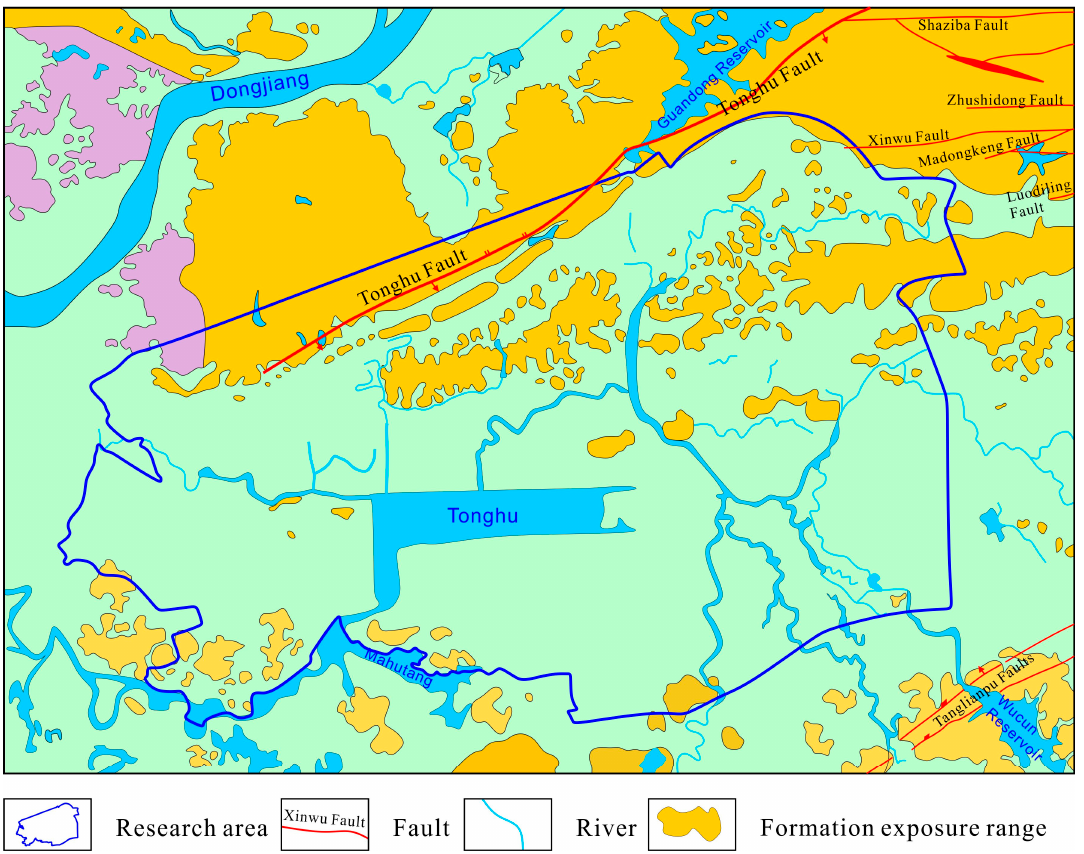
Figure 4. Distribution of faults in the study area .